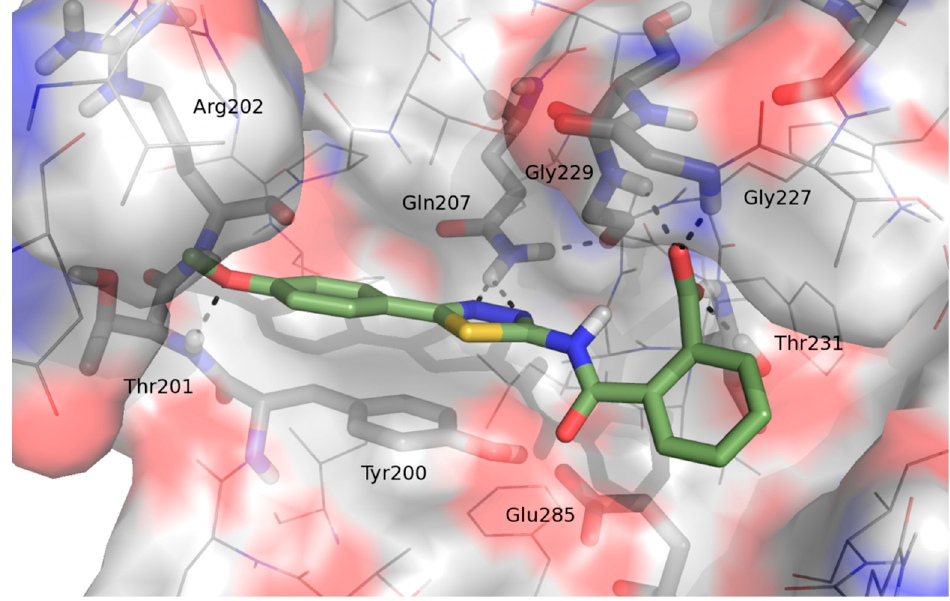
Figure 3. Binding mode of 1 within the ATP binding pocket of human DDX3.